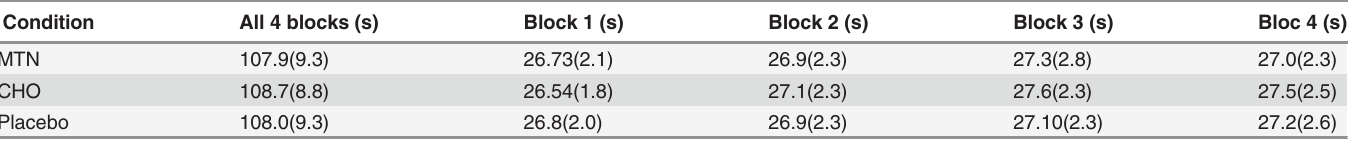
Table 1. Total 15-m sprint times (s) per block and the entire intermittent repeated sprint test.